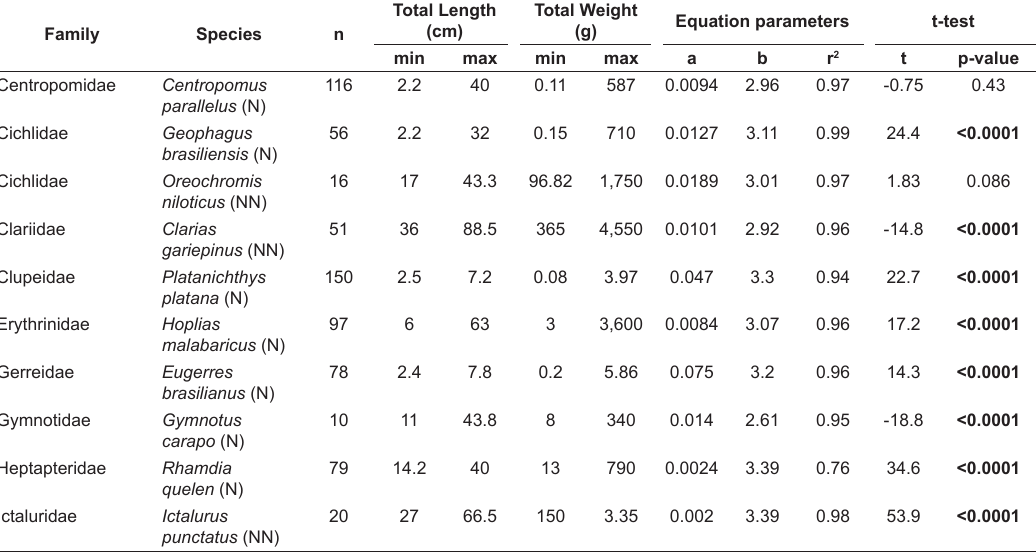
Table 1. Length-weight relationship parameters of ten fish species of Guaraguaçu River, Paraná, Brazil, sampled between 2004 and 2007. Equation parameters: scaling coefficient ( a ), allometric coefficient ( b ), and coefficient of determination ( r 2 ). Deviation from isometric growth ( b = 3) was tested by a Student’s t -test. Bold values denote p < 0.05. N is a native species and NN is a non-native species.